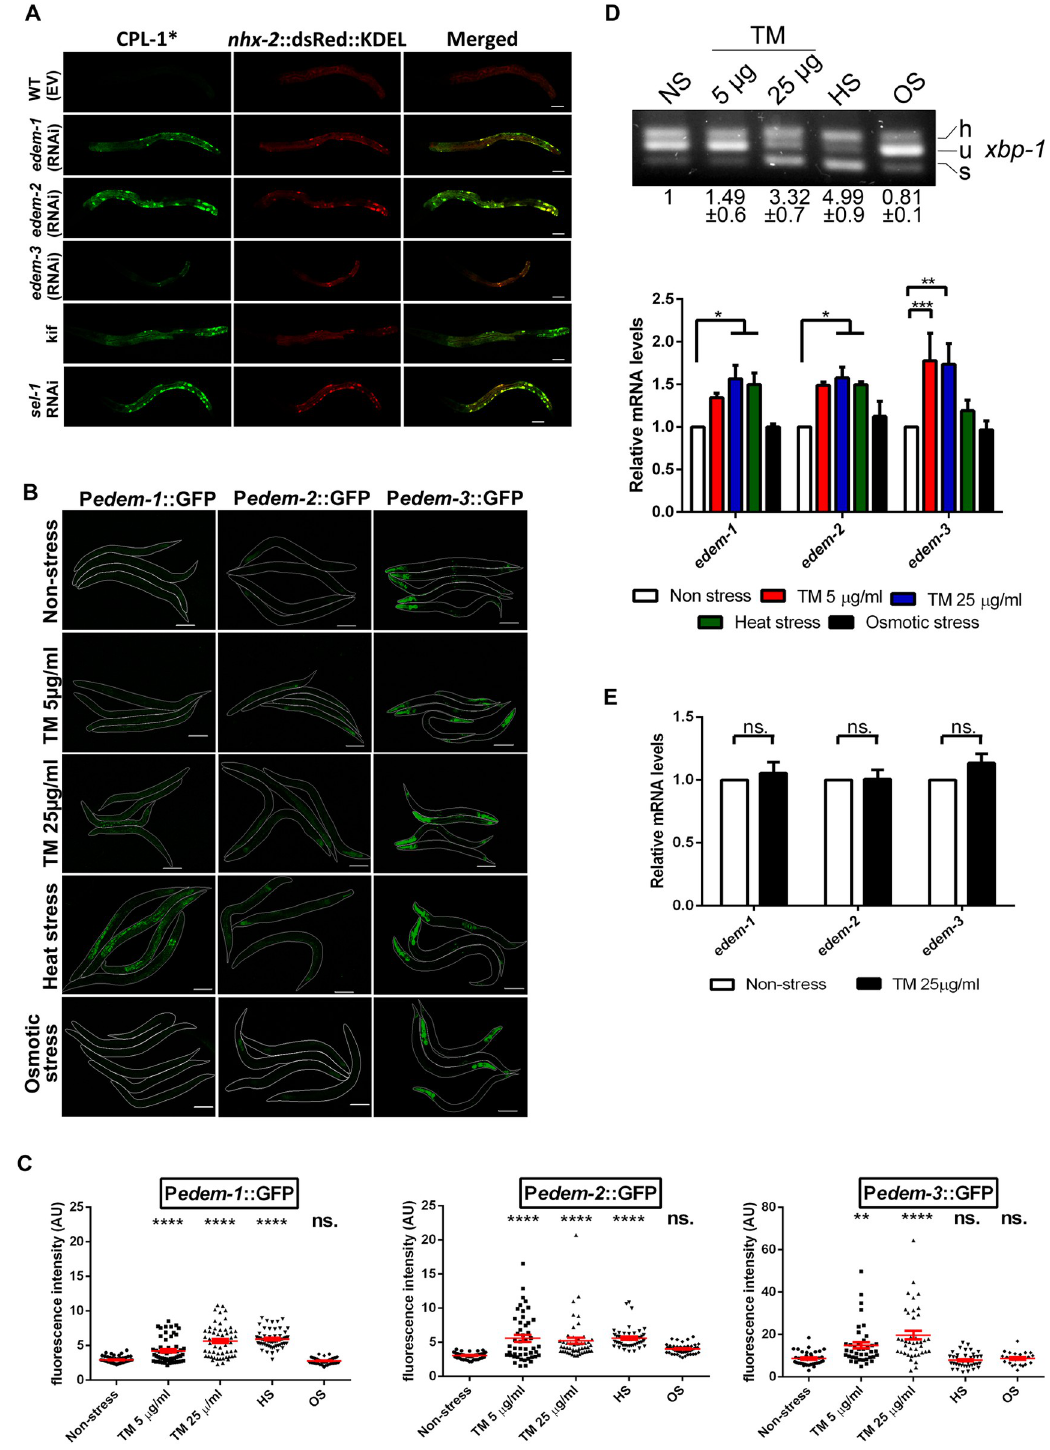
Fig 2. C . elegans edem genes have conserved functions in the clearance of misfolded proteins from ER. (A) RNAi downregulation of edem triggered accumulation of CPL-1 � in intestinal cells. CPL-1 � localized to ER, visualized with the ER marker nhx-2 ::dsRed::KDEL ( nhx-2 —Na/H eXchanger—is expressed in the apical membranes of the intestinal cells), in edem and sel-1 silenced animals. For kifunensine treatment (Kif) animals were kept on 30mM kifunensine for 24h before imaging. Scale bar: 20 μ m. (B-C) P edem ::GFP transgenes responded to the ER stress treatments: 5 μ g/ml and 25 μ g/ml tunicamycin for 6 h, heat stress